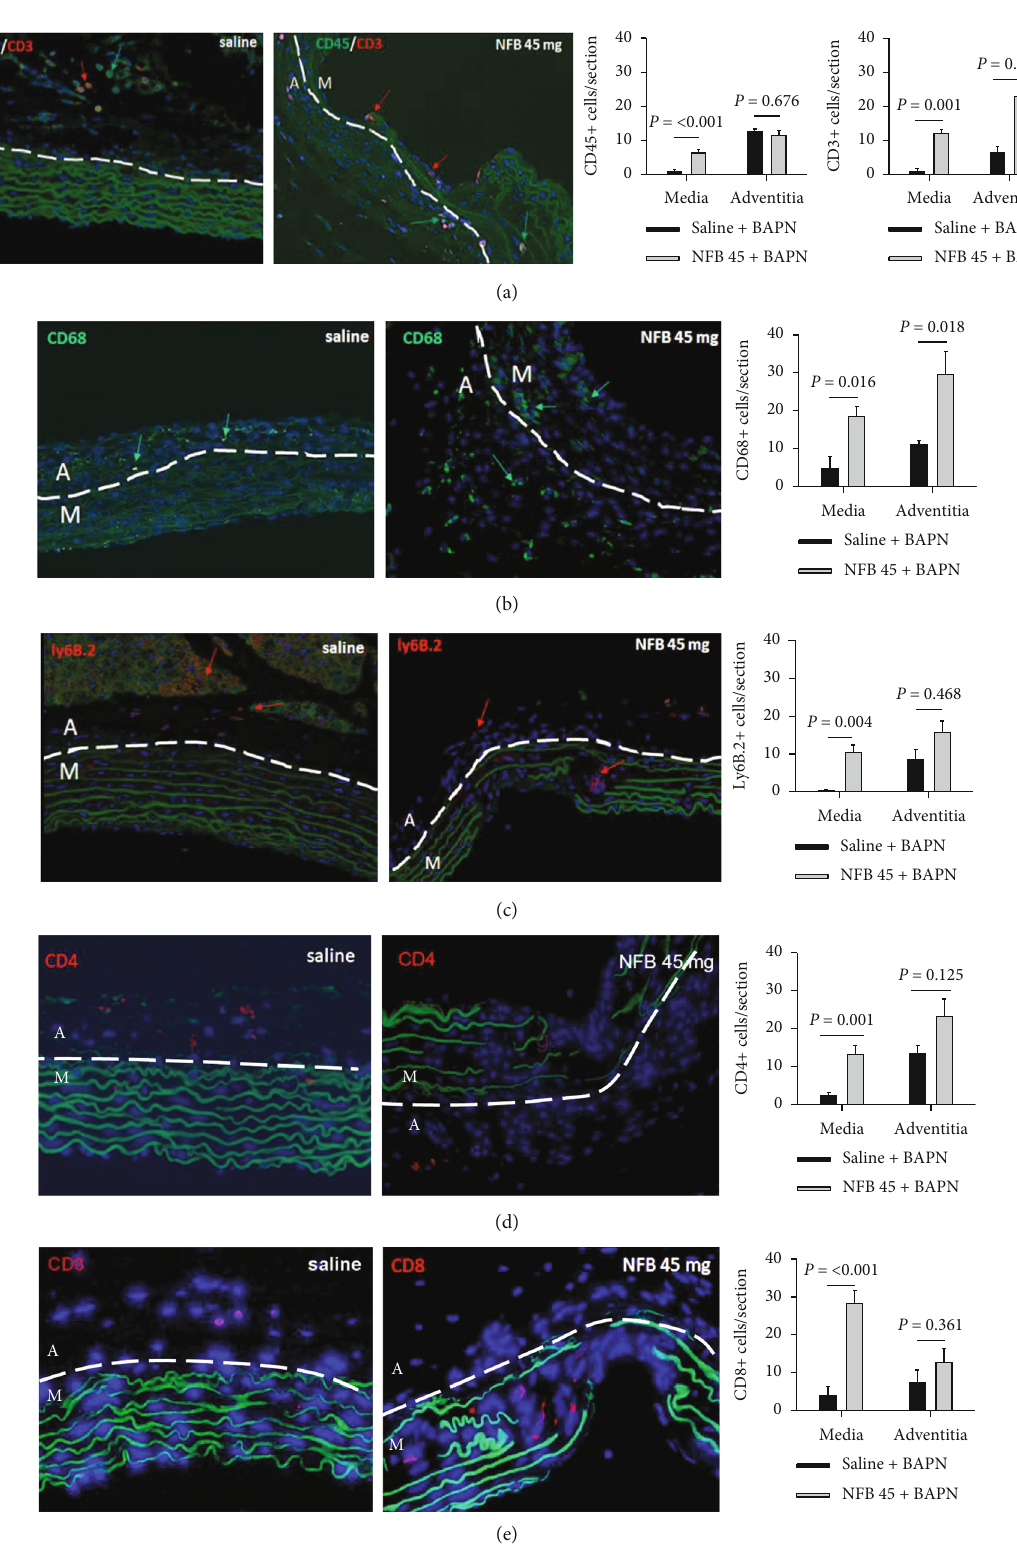
Figure 6: Treatment with nicotine free base (NFB) intensi fi es the chronic in fl ammation in TAADs. (a) Immuno fl uorescence (IF) double labeling of CD45+ leukocytes (green) and CD3+ T-cells (red). (b – e) IF labeling of macrophages (CD68+, green, (b)), neutrophils (Ly6B.2+, red, (c)), CD4+ T-cells (red, (d)), and CD8+ T-cells (red, (e)). Note that the in fl ammatory cells clustered largely in the area with structural destruction in NFB-treated TAADs, whereas in saline-treated TAADs, they were scattered sparsely across the aortic wall. A: adventitia; M: media; blue: DAPI counterstain. Data were analyzed using unpaired Student ’ s t -test ( n = 6 ‐ 9 per